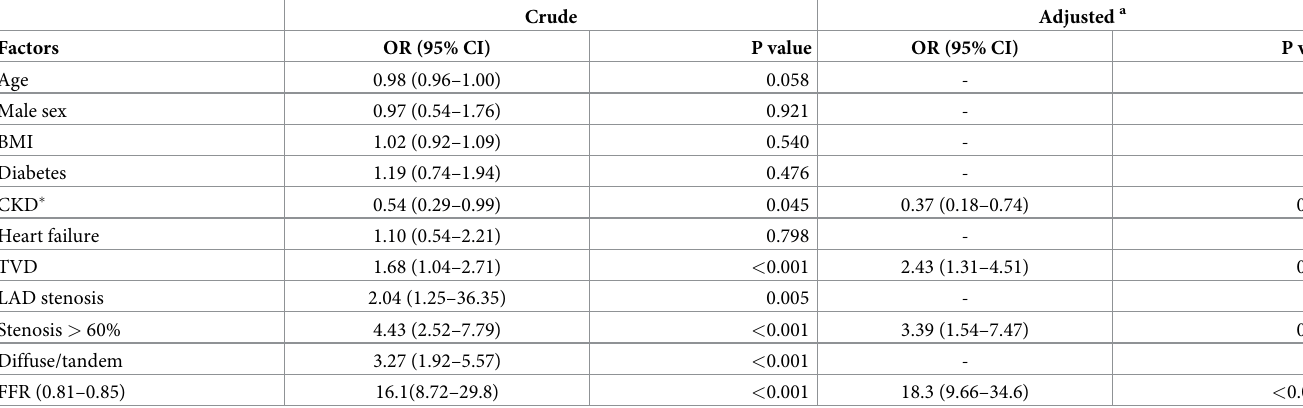
Table 3. Predictors of FFR � 0.8 at high-dose